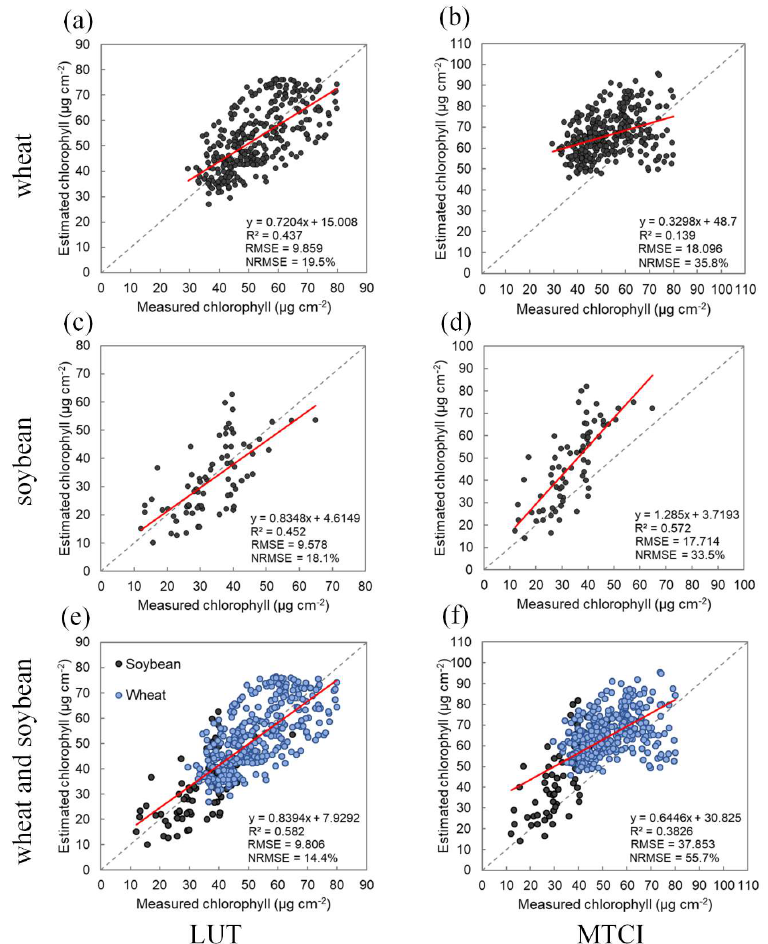
Figure 9. LCC retrieval performance for wheat and soybean using the LUT and the MTCI approach with the field-measured canopy spectra simulating the MERIS bandsets: ( a , c , e ) the retrieval results based on the LUT approach; and ( b , d , f ) the retrieval results based on the MTCI approach.